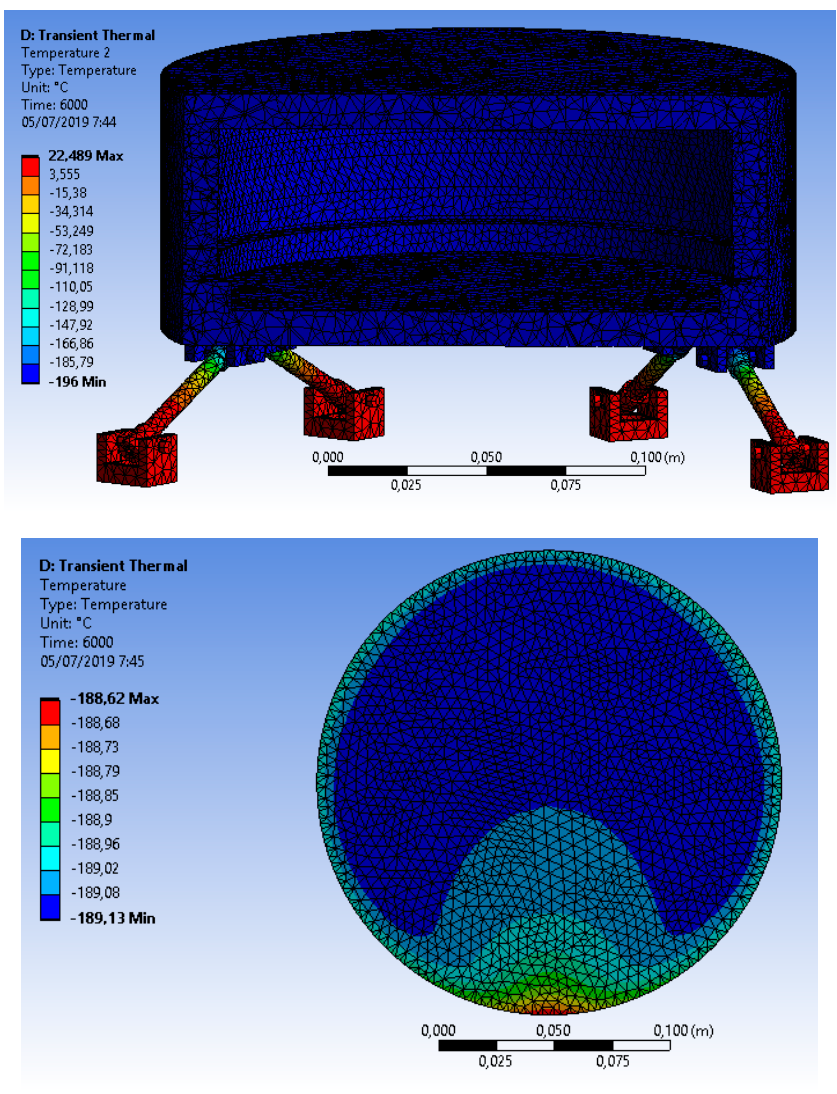
Figure 6. Temperature distribution in the whole structure ( top ), plane view and on the top surface of the structure ( bottom ).